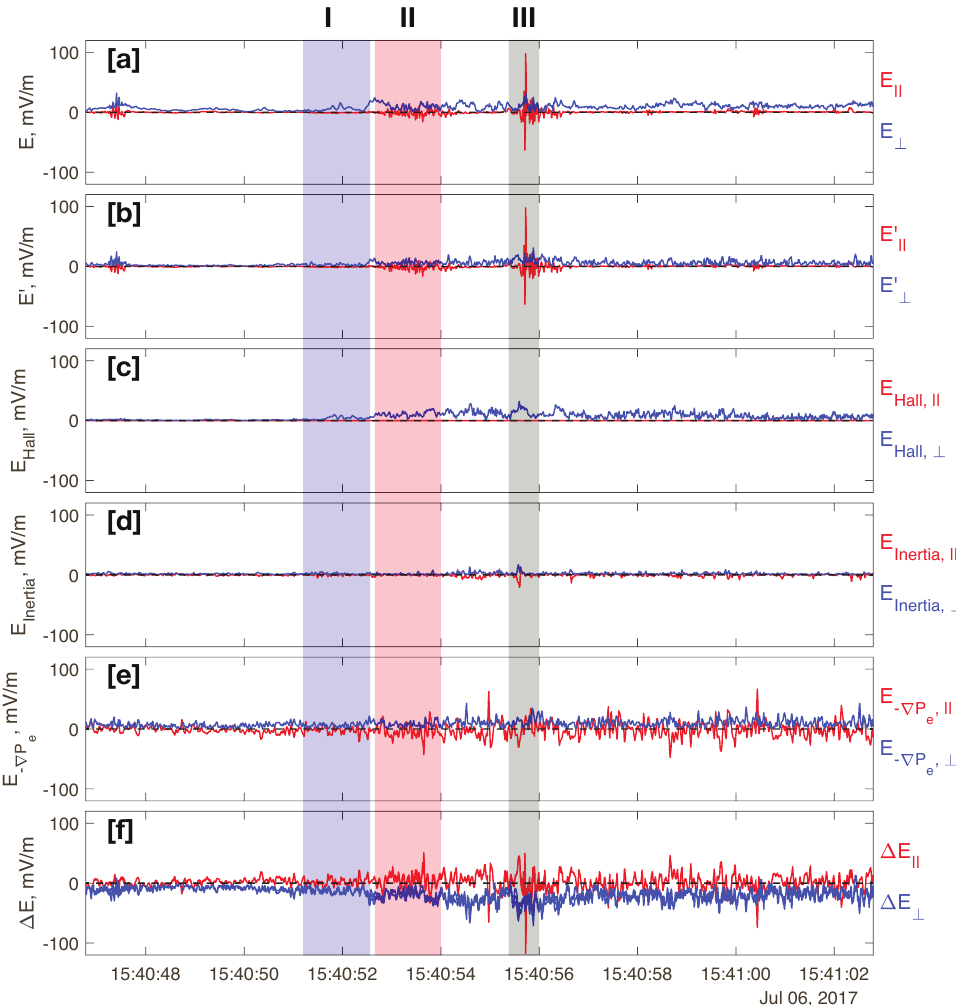
Figure 4. From top to bottom: the parallel and perpendicular components of the observed ( a ) E and ( b ) nonideal E (cid:48) electric fields; ( c ) Hall’s term, ( d ) inertia term and ( e ) pressure gradients term of the generalized Ohm’s law; ( f ) the difference between the nonideal electric field, E (cid:48) and the sum of three Ohm’s law